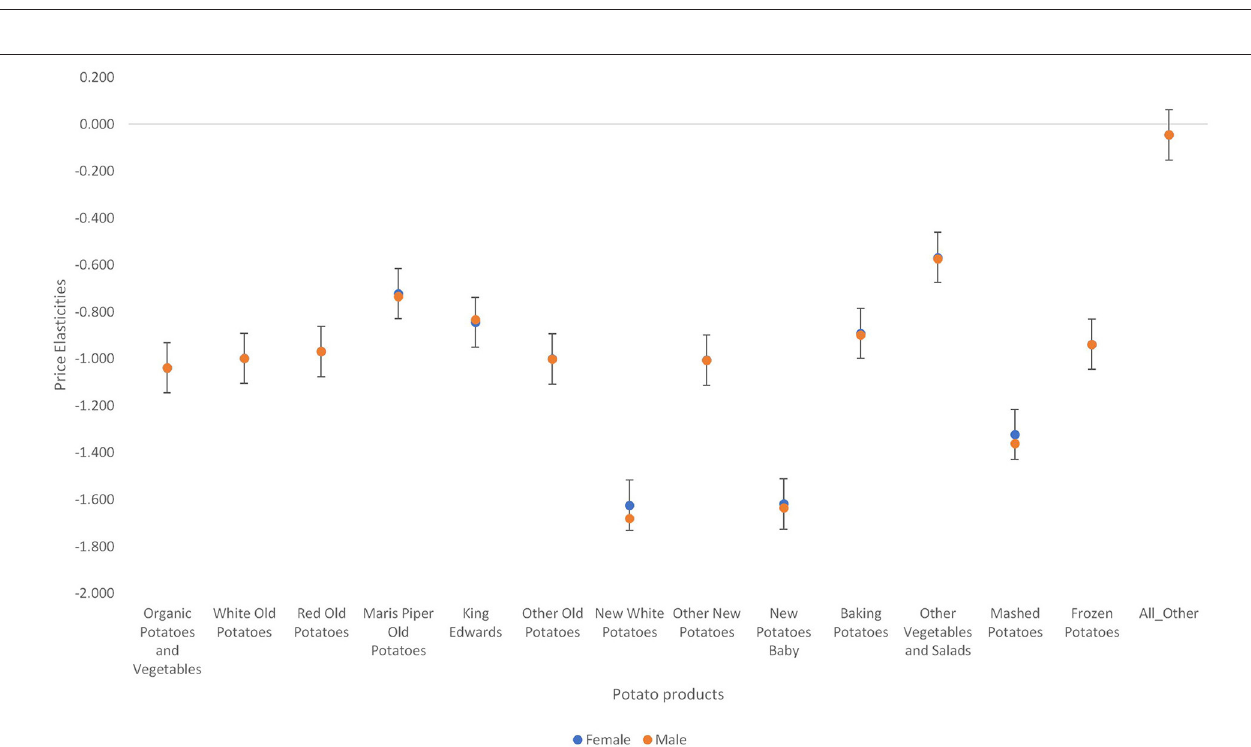
FIGURE 7 | Variations in own price elasticities across sexes in the United Kingdom.